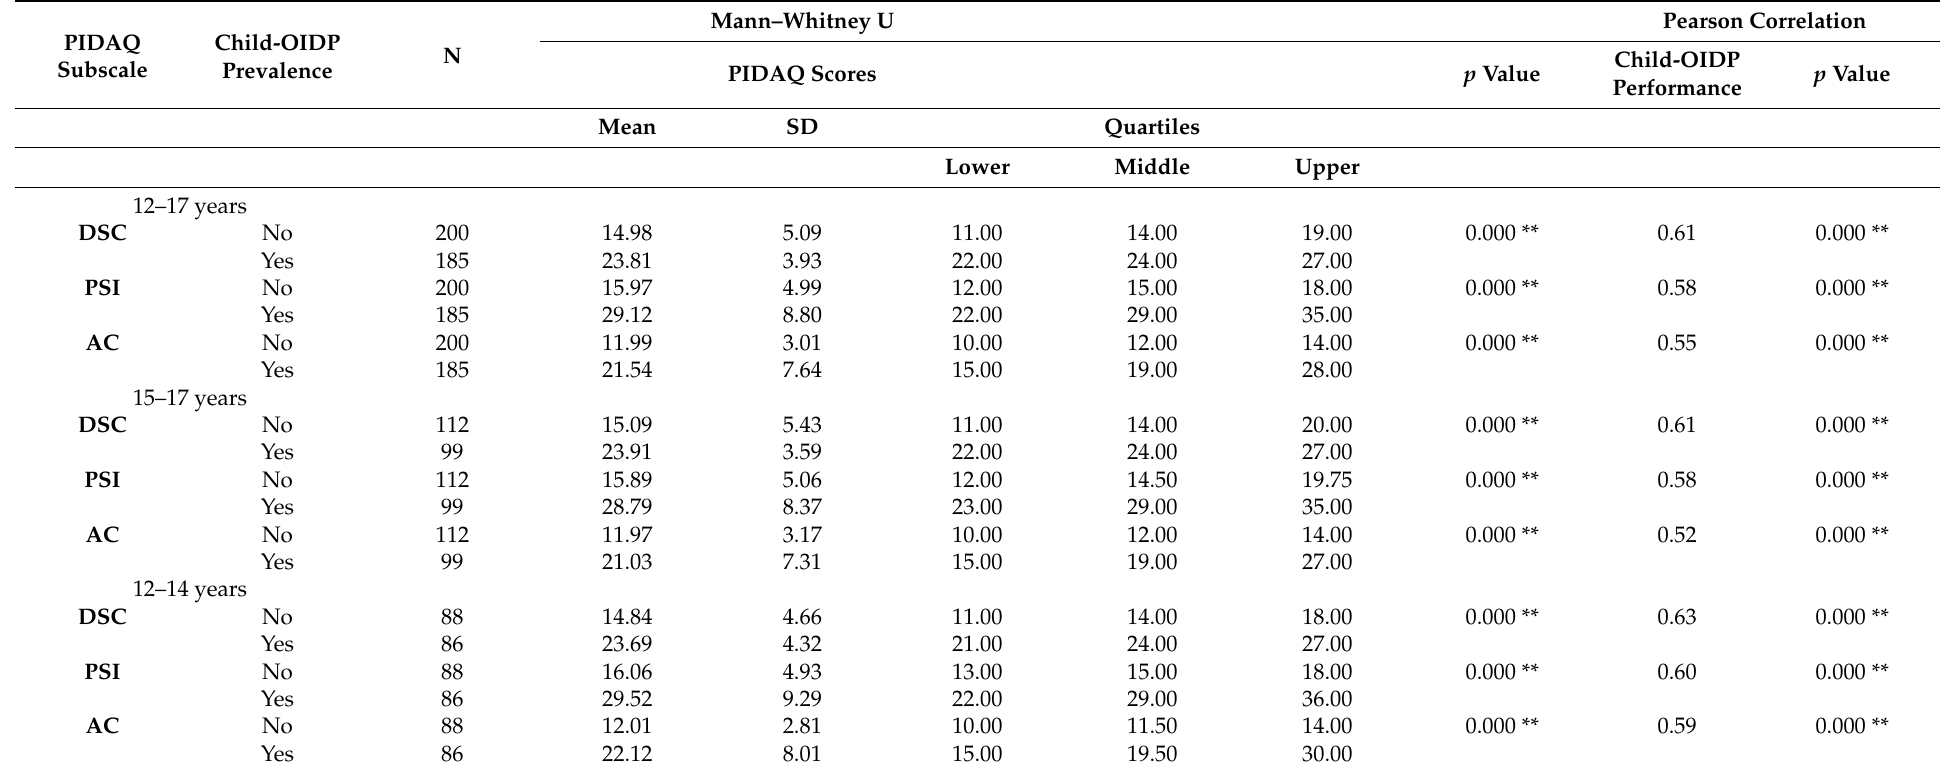
Table 5. Concurrent criterion validity of the